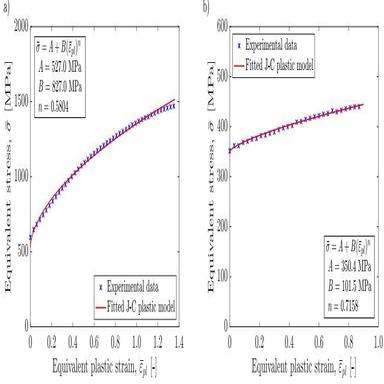
Experimental true equivalent stress - true equivalent plastic strain data fitted to Johnson-Cook plastic model: (a) stainless steel 304L; (b) copper C110.